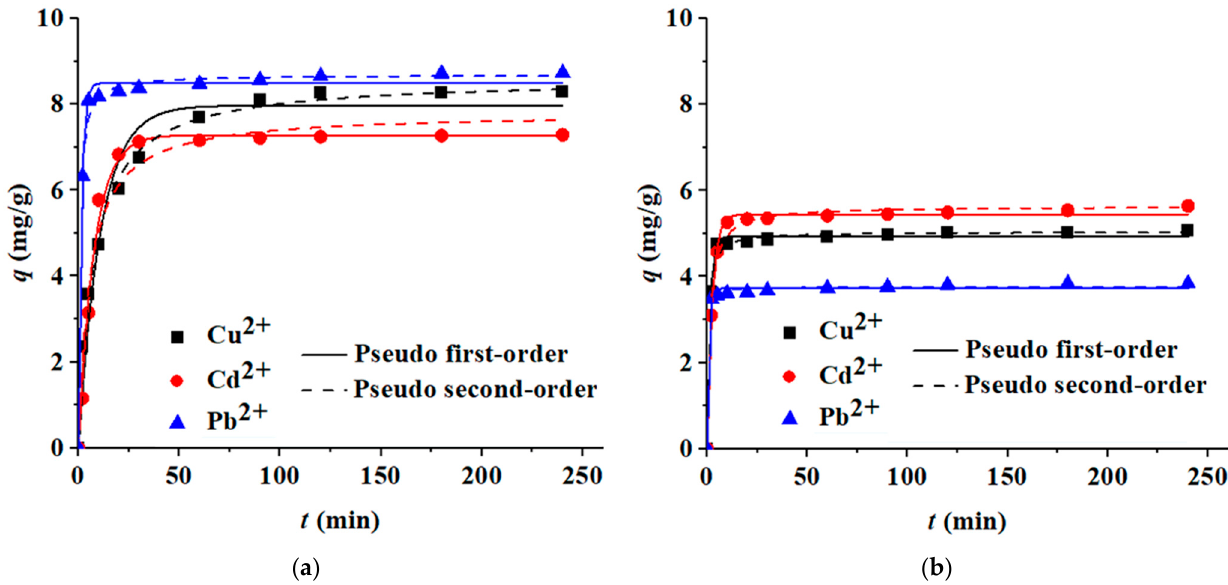
Figure 4. Adsorption kinetics of heavy metal cations (Cu 2+ , Cd 2+ , Pb 2+ ) onto the solid surface of oxidized wool fibers: ( a ) adsorption kinetics for one-component systems (sorbent dose = 5 g/L; initial concentration of metal ion C 0 = 50 mg/L; T = 300 K); ( b ) adsorption kinetics for competitive or multi-component system (sorbent dose = 5 g/L; initial concentration of each metal ion in the system was equal to 20 mg/L, summing up a total metal ions concentration of 60 mg/L; T = 300 K); solid lines represent predictions given by pseudo-first-order (PFO) kinetic model, and dash lines represent predictions given by pseudo-second-order (PSO) kinetic model.